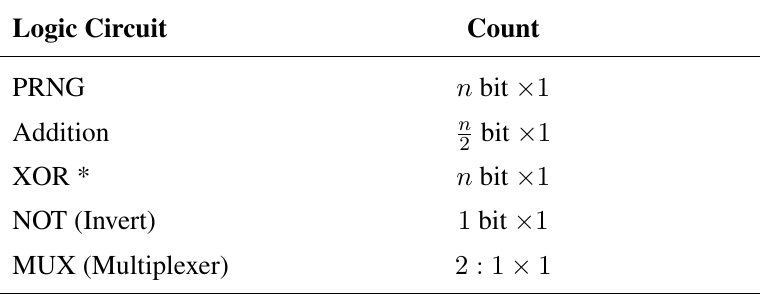
Table 4. Logic Circuit